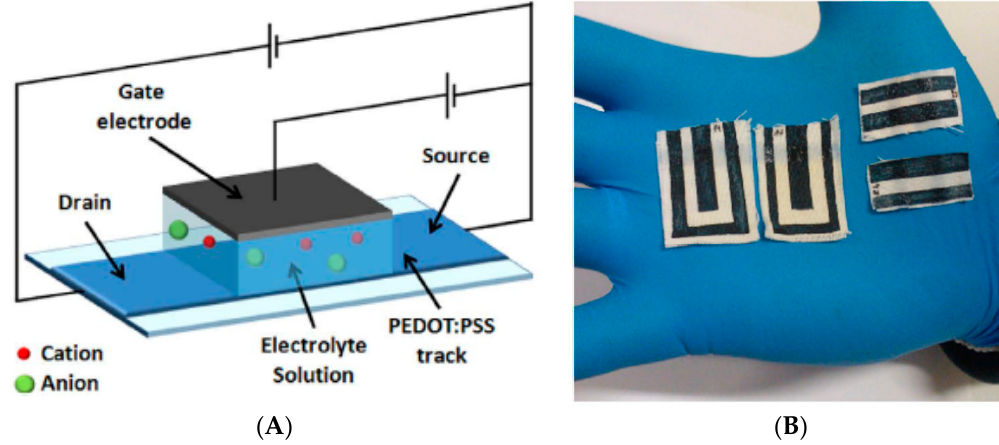
Figure 4 . ( A ) General scheme of an OECT. All components are in PEDOT:PSS. ( B ) Screen-printed OECTs (devices on the left, fabricated on woven cotton (250 μ m thick) and those on the right printed on a Lycra substrate). Reproduced from [31]. Creative Commons Attribution 4.0 International License. Copyright 2016 Springer Nature Publishing AG.